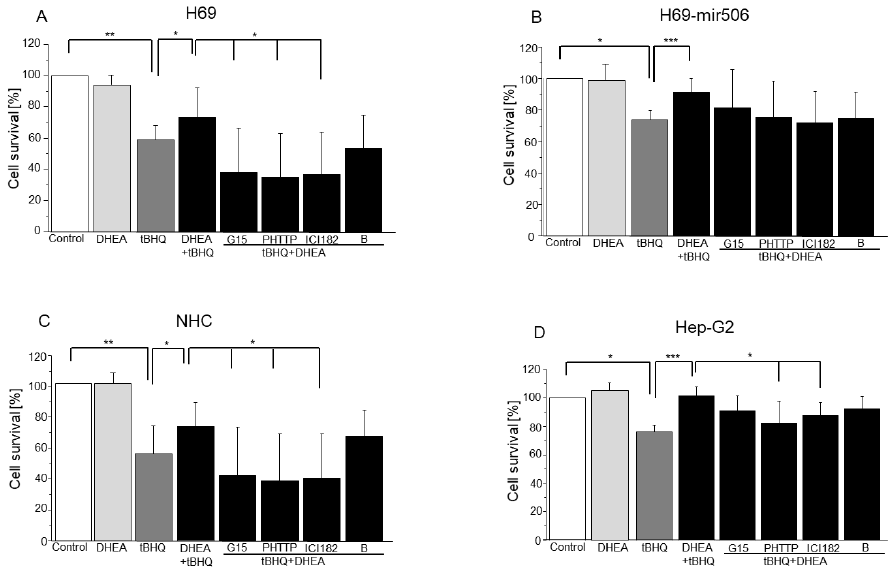
Figure 4. The role of estrogen and androgen receptors in DHEA protection against mitochondrial oxidative stress induced by tBHQ. Cells ( A – D ) were incubated with estrogen (GPER, ER- α , and ER- β ) or androgen receptor inhibitors i.e., G15 (12 nM); ICI 182,780 (2 nM); PHTTP (10 nM), and bicalutamide ( B ) (10 nM), followed by DHEA and tBHQ co-treatment. To evaluate the viability of examined cells, MTT assays were conducted. Results are presented as mean ± SEM ( n = 3); * p < 0.05, ** p < 0.01, *** p < 0.001.